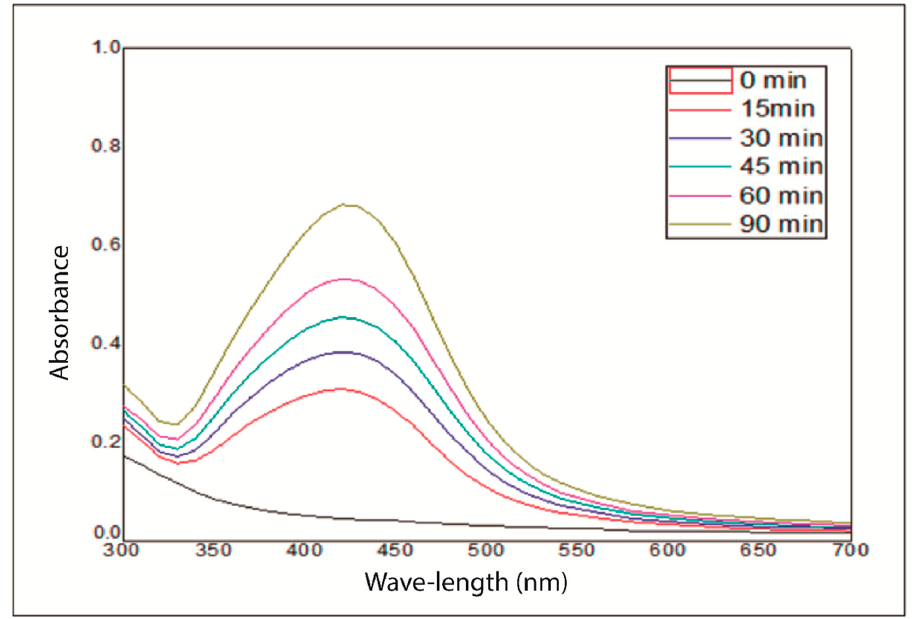
Figure 1. Absorbance of AgNPs-RR